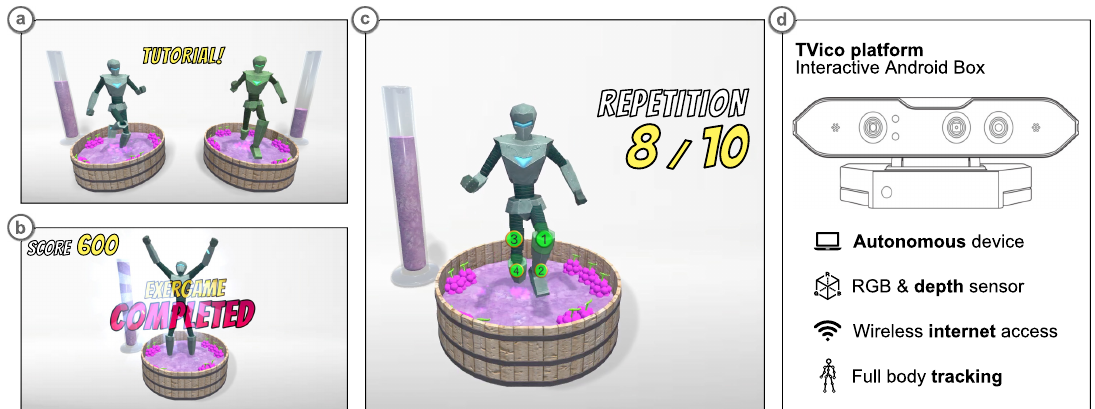
Figure 6. Screenshots of developed exergame from devised functionality in gamification module: ( a ) Tutorial view. ( b ) Results view. ( c ) Participation view. ( d ) Autonomous device